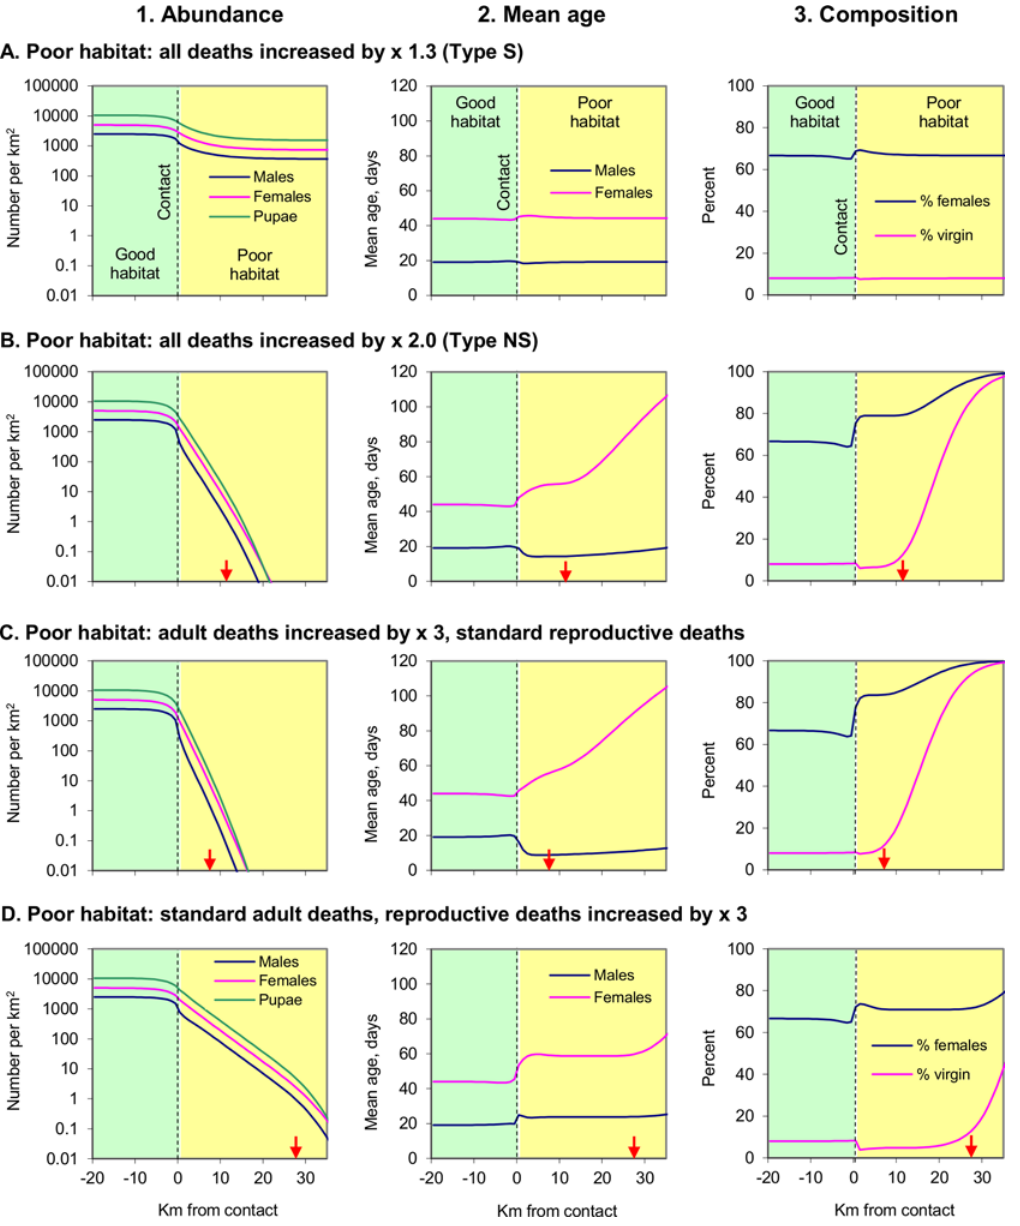
Fig 1. Population data associated with adjoining habitats. Abundances (1) and mean ages of adult male and female tsetse (2), and percents (3) of females among all adults and of virgins among all females, at various distances from the contact between good and poor habitats, when the poor was associated with: all deaths increased 1.3 times (A), all deaths increased 2.0 times (B), adult deaths increased 3.0 times but standard reproductive deaths (C), and standard adult deaths but reproductive deaths increased 3.0 times (D). Good and poor habitats are shaded green and yellow, respectively. Red arrows show where mature males became so scarce that the daily probability of a mature virgin female finding a mate fell below 10%. Absence of a red arrow signifies no such fall in mating-finding